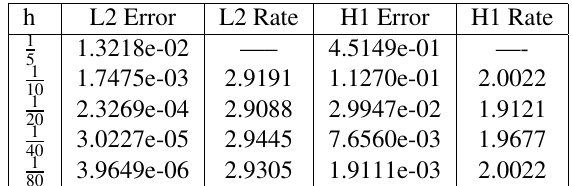
Table 2. Errors for Quadratic IFEM at final time for β + = 1 and β − = 5, ∆ t = h /